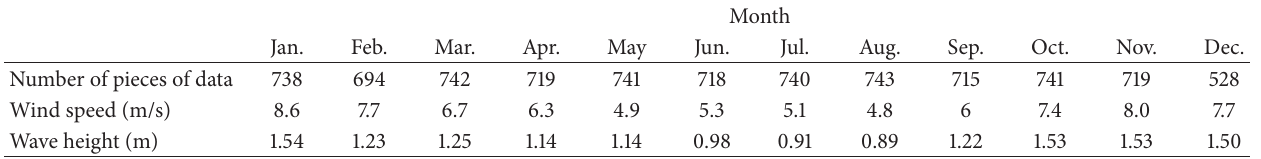
Table 3: Average wave height and wind speed per month in